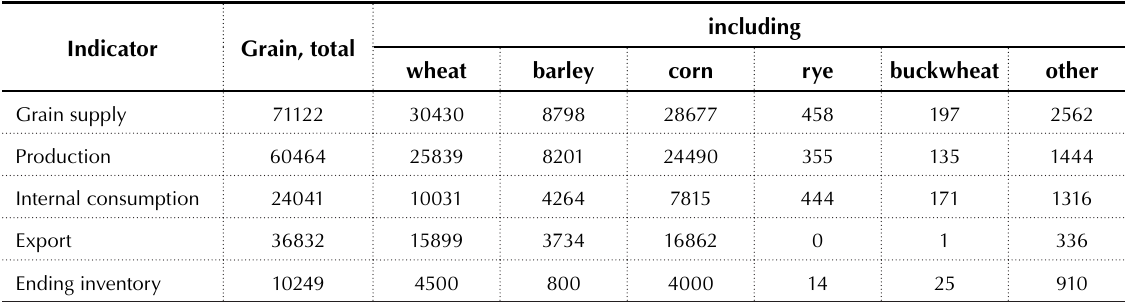
Table 4. The balance of grain in 2015–2016, thousand